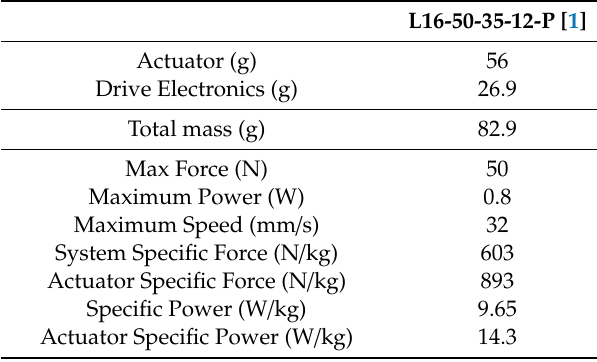
Table 6. Electronic screw actuator component weights and specific force and